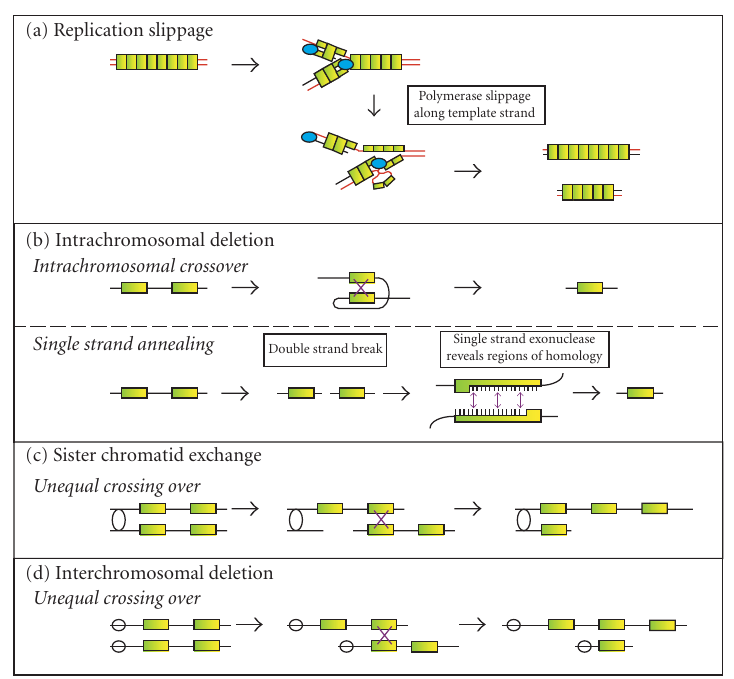
Figure 1. Mechanisms of deletion. (a) Replication slippage, where DNA polymerase dissociates from its template and reanneals to homologous sequences nearby resulting in either a deletion (shown) or insertion (not shown) of sequences. These tend to be relatively small deletions or insertions and are usually in regions of repetitive DNA. (b) Intrachromosomal or intrachromatid deletion may be mediated by a number of di ff erent mechanisms, two of the most likely being a crossover event and single strand annealing. A crossover event is mediated by aligning homologous sequences, strand invasion, possibly following a single-stranded break, allows strand exchange and recombination between the two homologous sequences. The result is a deletion of the intervening sequences. Single strand annealing is another likely mechanism that requires a double strand break between the homologous sequences. A single strand exonuclease can degrade one strand at the DNA ends until homology is revealed allowing the broken ends to anneal and the intervening sequences to be clipped o ff . (c) Interchormatid deletion is most likely to result from an unequal crossover event, only occuring in G2 after the chromatid has been replicated but before they are segregated. Again, the event is mediated by a repeated region of homology, but in these events two products are formed, a deletion and a triplication on the two resultant recombinant chromosomes. (d) Interchromosomal deletion is similar to interchromatid deletion except that the interaction is between homologous